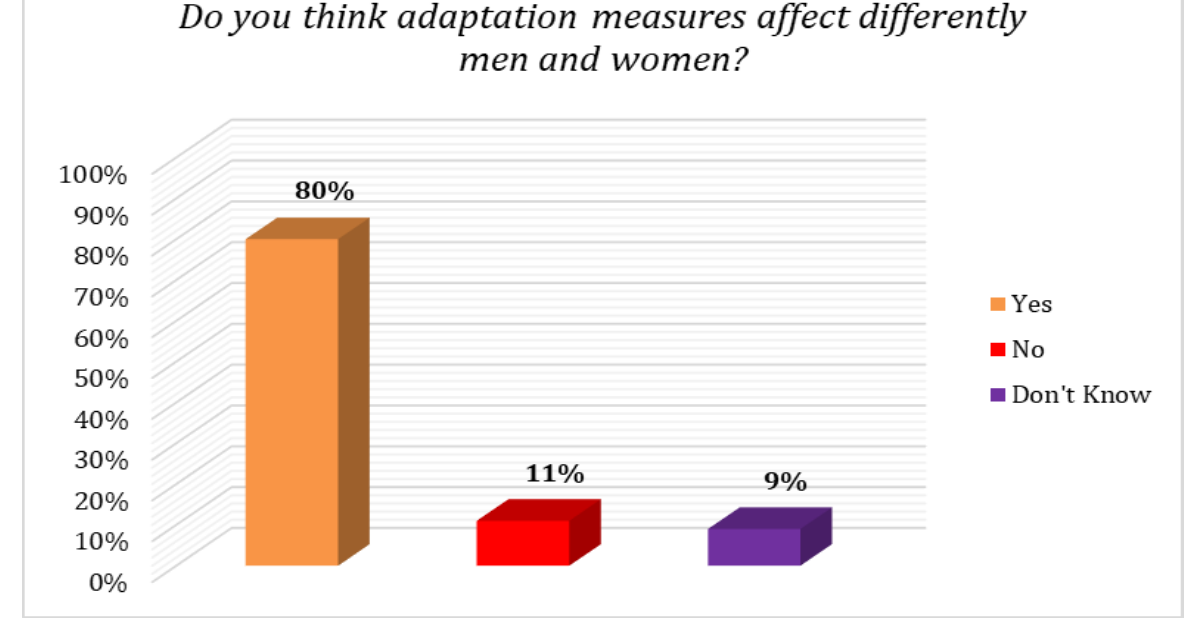
Figure 4. Affects of adaptation measures on men and women; Source: Field Survey, 2017–2019. [Whereas, Yes (male 55.5%, female 24.5%); No (male 7.63%, female 33.7%); don’t know (male 6.24%, female 2.76%).